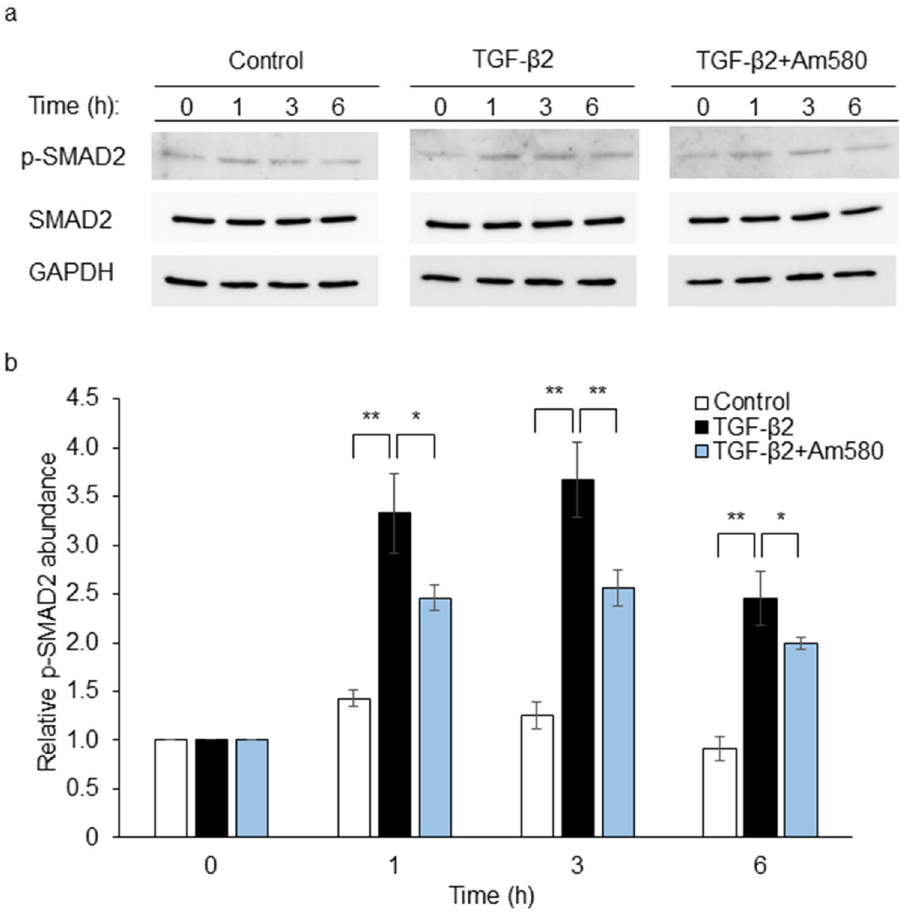
Figure 6. Inhibitory effect of an RAR-α agonist on TGF-β2-induced SMAD2 phosphorylation in RPE cells. ( a ) Serum-deprived RPE cells were cultured in 24-well plates with or without Am580 (10 μM) for 6 h and then in the additional absence or presence of TGF-β2 (1 ng/ml) for the indicated times. Cell lysates were then prepared and subjected to immunoblot analysis with antibodies to total or phosphorylated (p-) forms of SMAD2 and to GAPDH (loading control). ( b ) The intensity of each phospho-SMAD2 band was normalized by that of the corresponding total SMAD2 band, and the normalized values were expressed relative to that for control cells at 0 h. Data are means ± s.d. from four independent experiments. The intensity of each immunoreactive bands was measured with the use of the Gels commands in ImageJ software. * P < 0.05, ** P < 0.01 (Dunnett’s